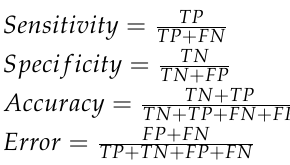
Figure 14. ( a ) Overall indicators for fall case; ( b ) Normal and Fall Indicator for sitting motion; ( c ) Normal and Fall indicators for squatting motion. ( b , c ) indicate normal cases. When the normal indicator is ‘ON’ and the fall indicator is 'OFF', it is interpreted as the 'Normal State' in case of sitting and squatting motion.